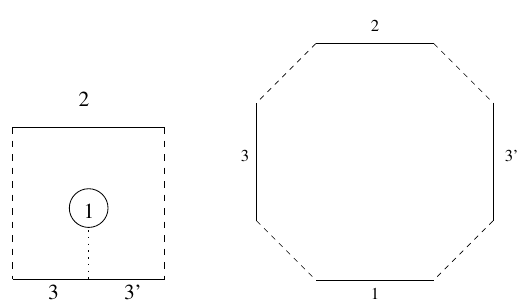
Figure 2 . The kinematical domains of the DSFT vertex is on the left, while that of the octagon amplitude is on the right. The glued mirror edges between #31 and #3’1 are indicated by a dotted line. The (cid:12)nite size string represented by the circle serves as a non-local operator insertion in the square